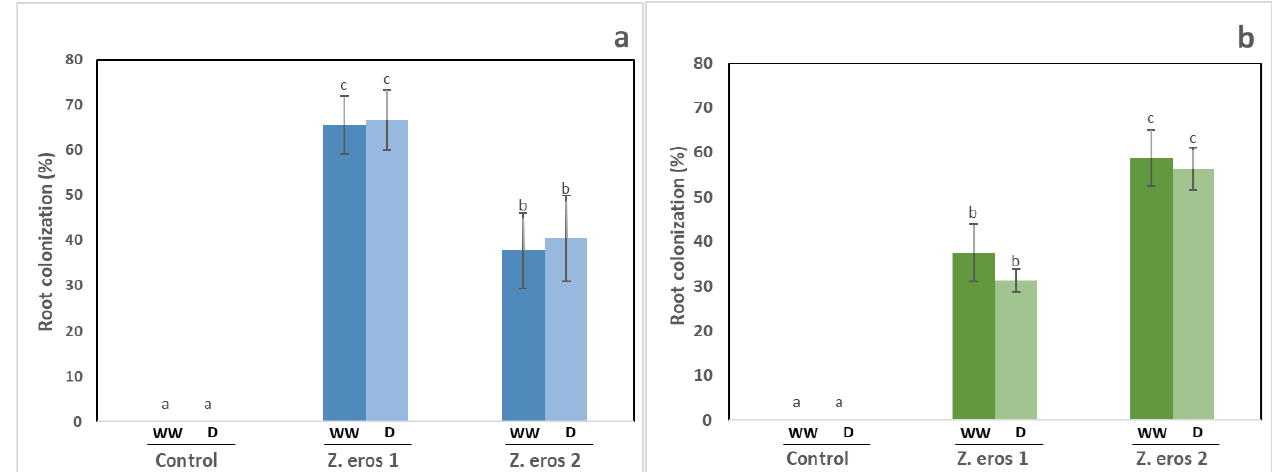
Figure 2. Percentage of root colonization in wheat plants ( a ), tomato plants ( b ) inoculated with the fungal endophytes Z. erostrata 1 y Z. erostrata 2 and cultivated under well-watered (WW) or drought stress (D) conditions. The data are the means ± standard deviation of ten replicates. According to Duncan’s multiple-range test ( p < 0.05), different letters indicate significant differences between all treatments.